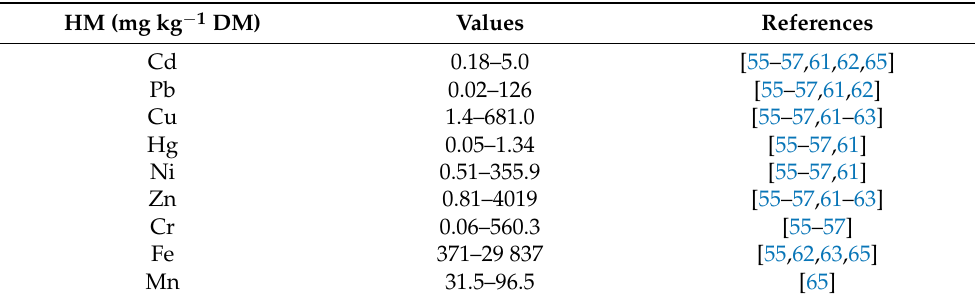
Table 4. HM content in DGs obtained after AD of different